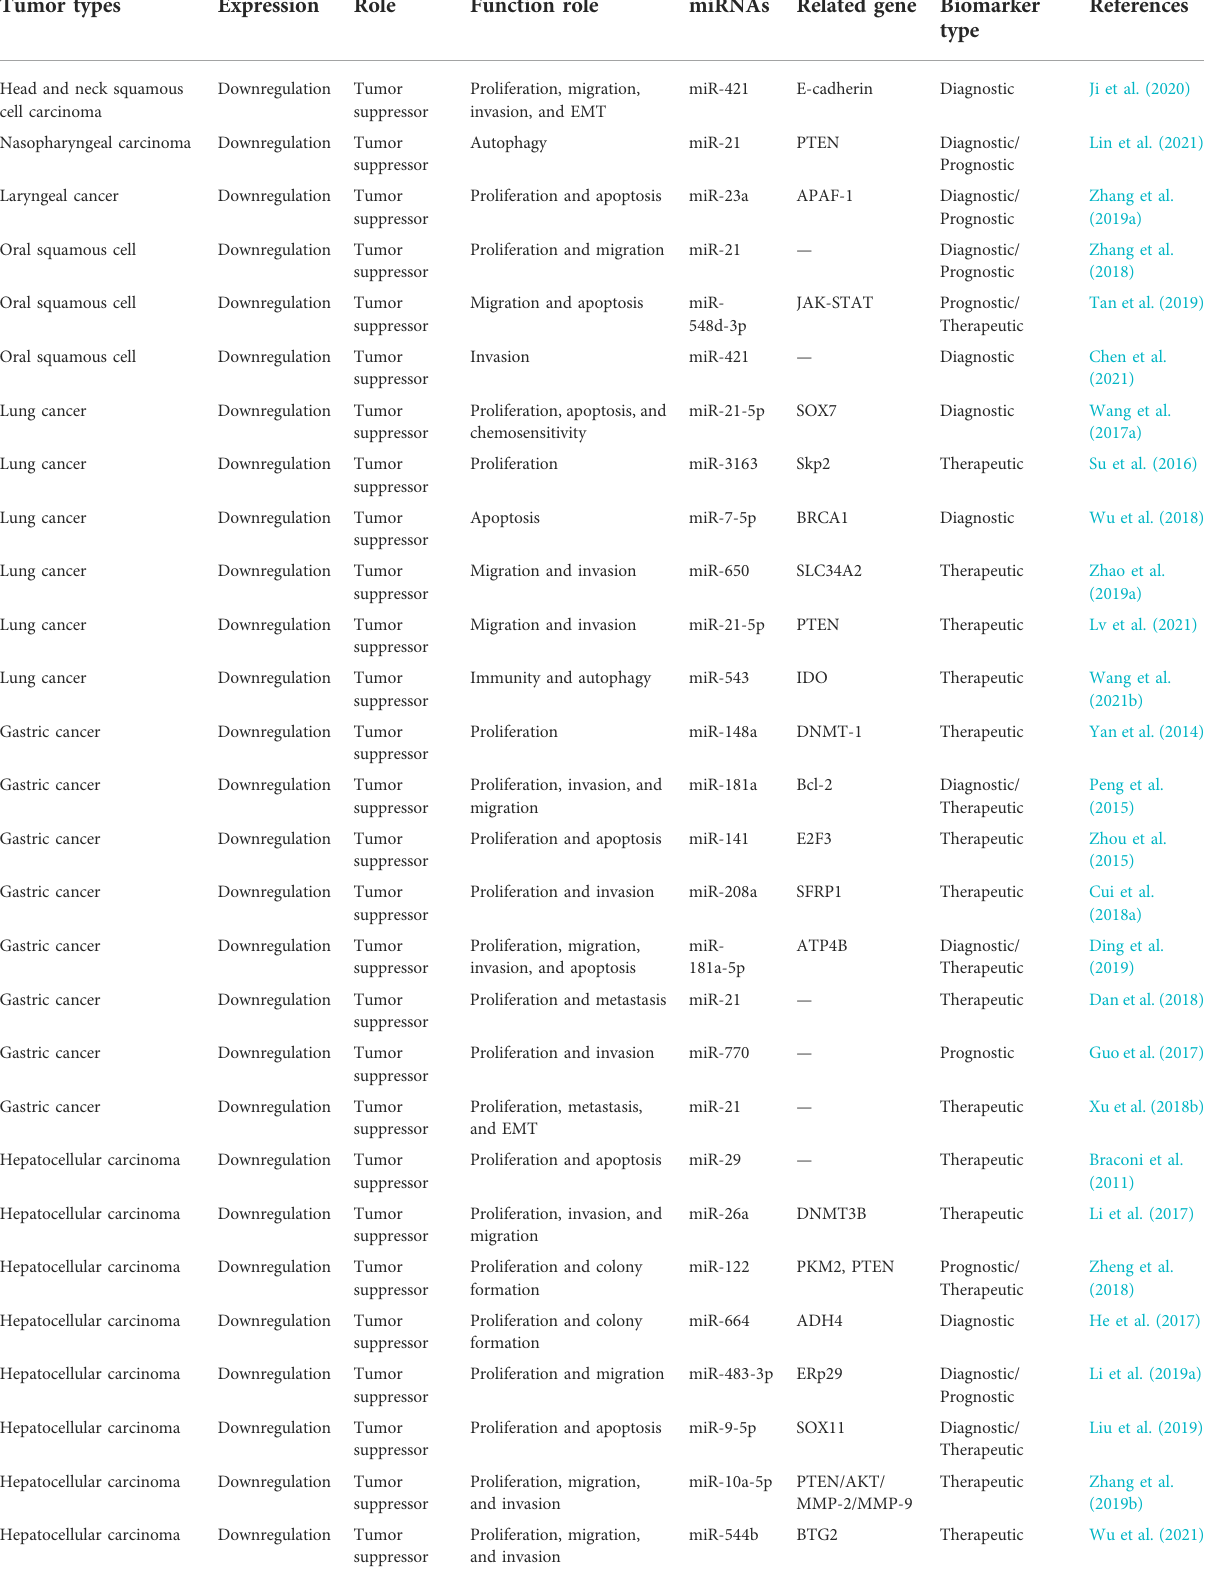
TABLE 1 Characterization of MEG3 function in respiratory and digestive system